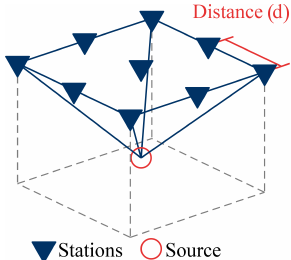
Figure 3. Placement of the nine stations used as receivers for testing the influence of the inter-station distance ( d ). The middle receiver is directly above the